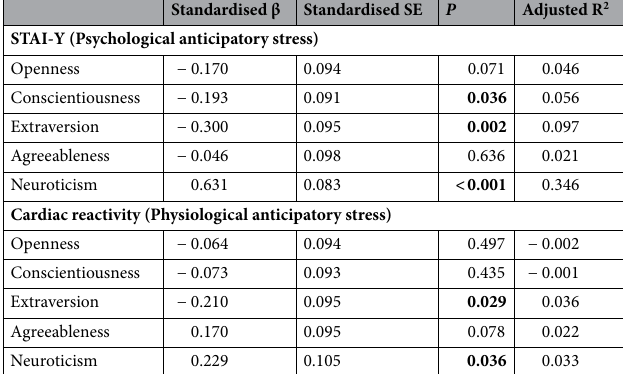
Table 3. Adjusted regression models for each personality trait and anticipatory stress (STAI-Y and cardiac reactivity) (n = 120). Significant relationships of the model analyses are in bold. SE is the standard error. STAI-Y : State Anxiety